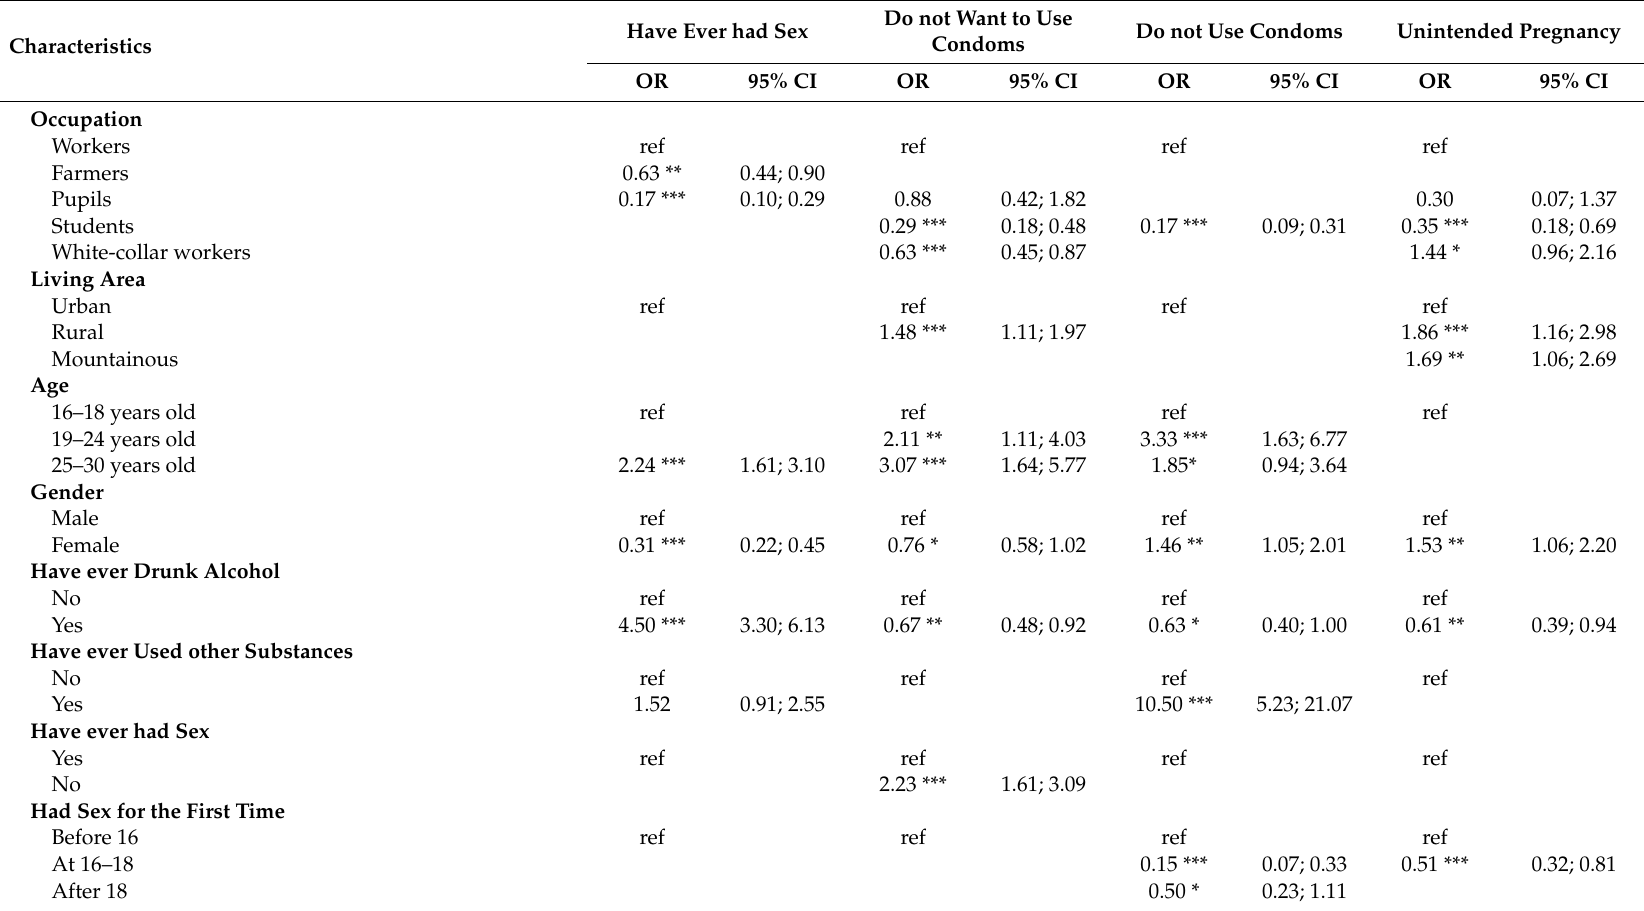
Table 3. Associated factors with attitude and practice on sexual